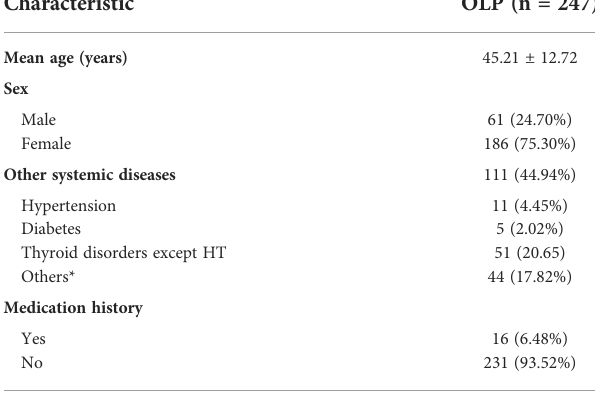
TABLE 1 Demographics information of the 247 patients with